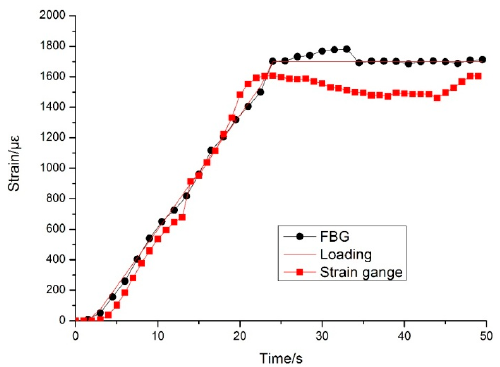
Figure 7. Strain measured by the FBG sensor and the strain gauge during the loading process.